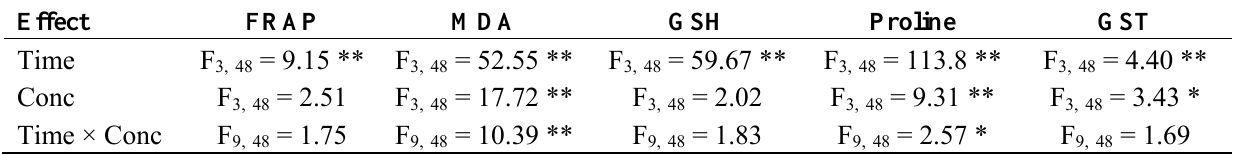
Table 2. Results of two-way analysis of exposure time and Cd concentration on the concentration of GSH, MDA and proline, total antioxidant capacity (FRAP) and GST activity of germinating soybean seed extract.